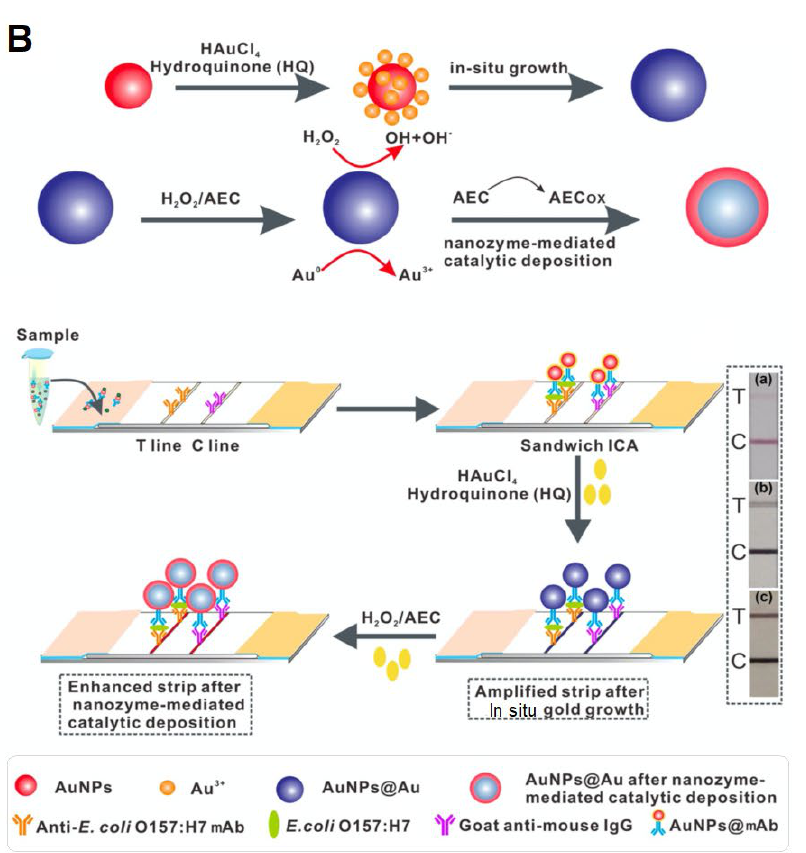
Figure 5. Colorimetric sensing strategy based on the accumulation of NPs. ( A ) Detection of staphylo- coccal enterotoxin B based on color readout by concentrated AgNPs on the lateral flow immunoassay (LFIA) strip. Reprinted with permission from [65]. Copyright 2020, Elsevier. ( B ) Detection of Es- cherichia coli O157:H7 based on color readout by concentrated AuNPs on the LFIA strip. This system consisted of a combination of two methods for cascade signal amplification. Reprinted with permis- sion from [70]. Copyright 2020, American Chemical Society. AEC, 3-amino-9-ethylcarbazole; ICA, immunochromatography assay; SEB, staphylococcal enterotoxin B; mAB, monoclonal